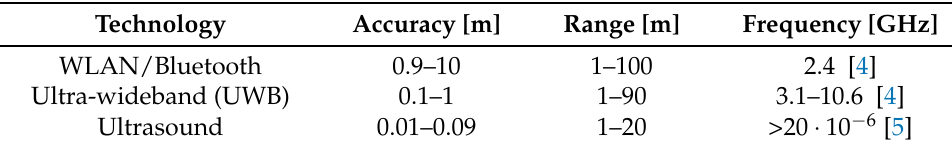
Table 1. Overview of radio frequency technologies for indoor positioning [3].